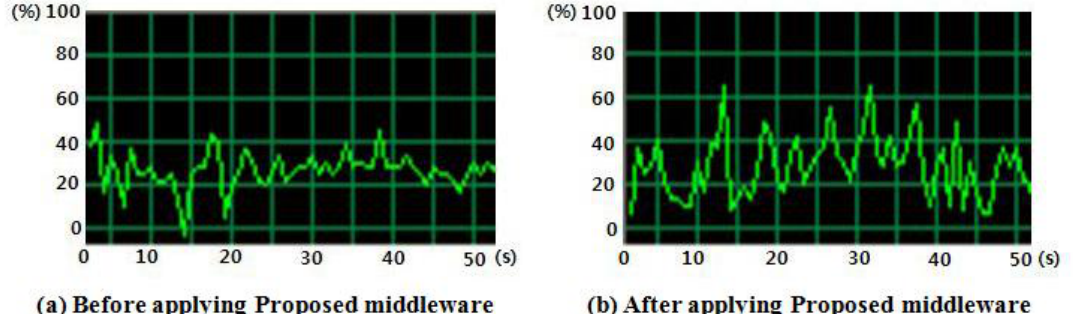
Figure 19. Usage of